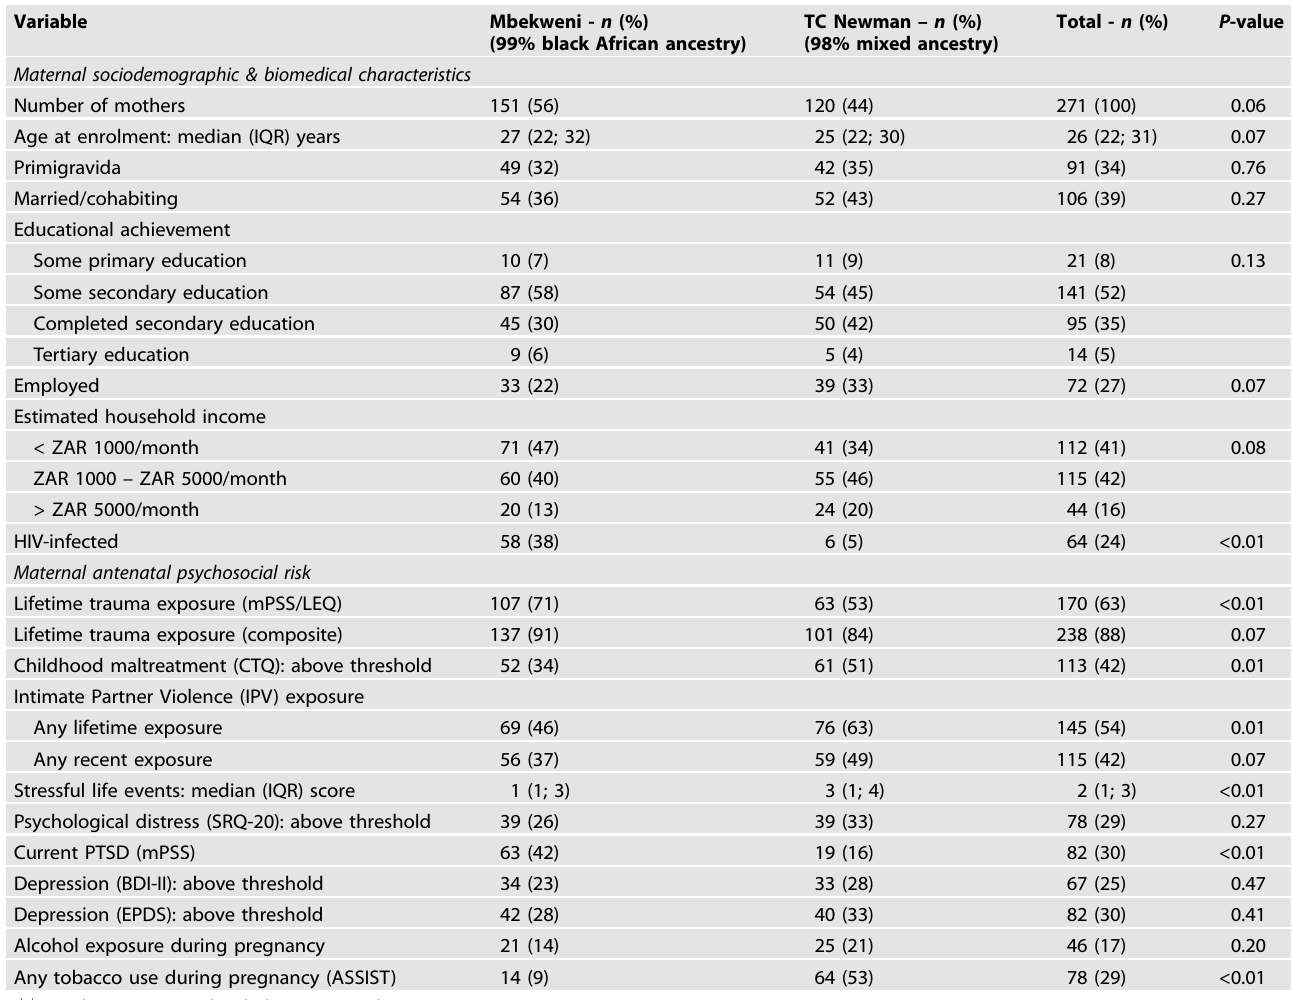
Table 1. Maternal sociodemographic characteristics and antenatal psychosocial risk ++